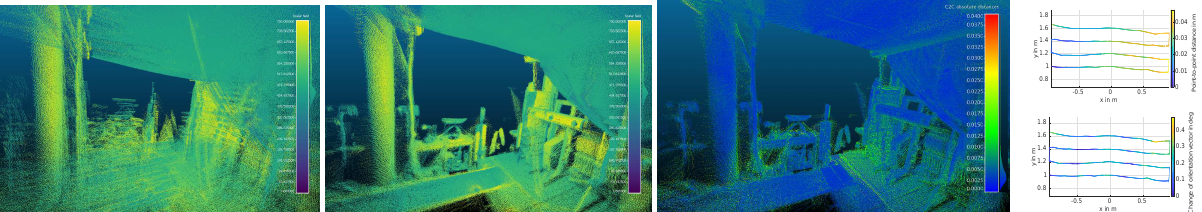
Figure 11. Linear Distortion: Left: Input point cloud. Middle: Corrected point cloud. Right: Error between corrected and reference point cloud. Plots: Above: Point to point distance between the corrected and original trajectory. Below: Change of orientation vector between the corrected and original trajectory.